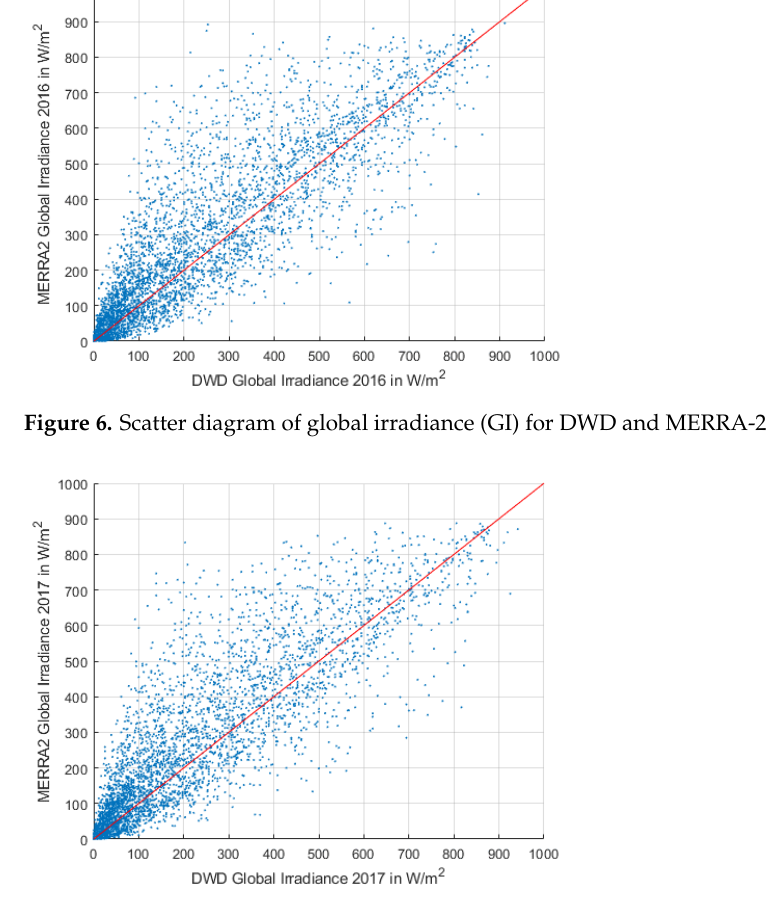
Figure 7. Scatter diagram of global irradiance (GI) for DWD and MERRA-2 in 2017 in Bremen. As it can be seen, the diagrams are by some means linearly distributed along the reference line. The data points are more expanded with higher amounts of irradiance. This is expected since the errors between two datasets are minimal in hours of no radiation or zero irradiance. Another point is that MERRA-2 mainly offers somewhat higher irradiance amounts in comparison with DWD. In other words, it slightly overestimates the irradi- ance. However, the distribution of both datasets in both years look highly correlated. For a better comparison in correlation, it is necessary to calculate the correlation coefficient. Considering DWD as the reference data, the correlation coefficient for global irradi- ance in Bremen between DWD and MERRA-2 datasets for 2016 is 0.9164, which indicates that the datasets are highly correlated. This factor for year 2017 is 0.9145, which is slightly less than 2016. Figures 8 and 9 illustrate the scatter diagrams for surface temperature in both da- tasets for the years 2016 and 2017. As it is shown, the data are highly correlated and dis- tributed almost linearly according to the reference line. Figure 8. Scatter diagram of surface temperature (TS) for DWD and MERRA-2 in 2016 in Bremen.